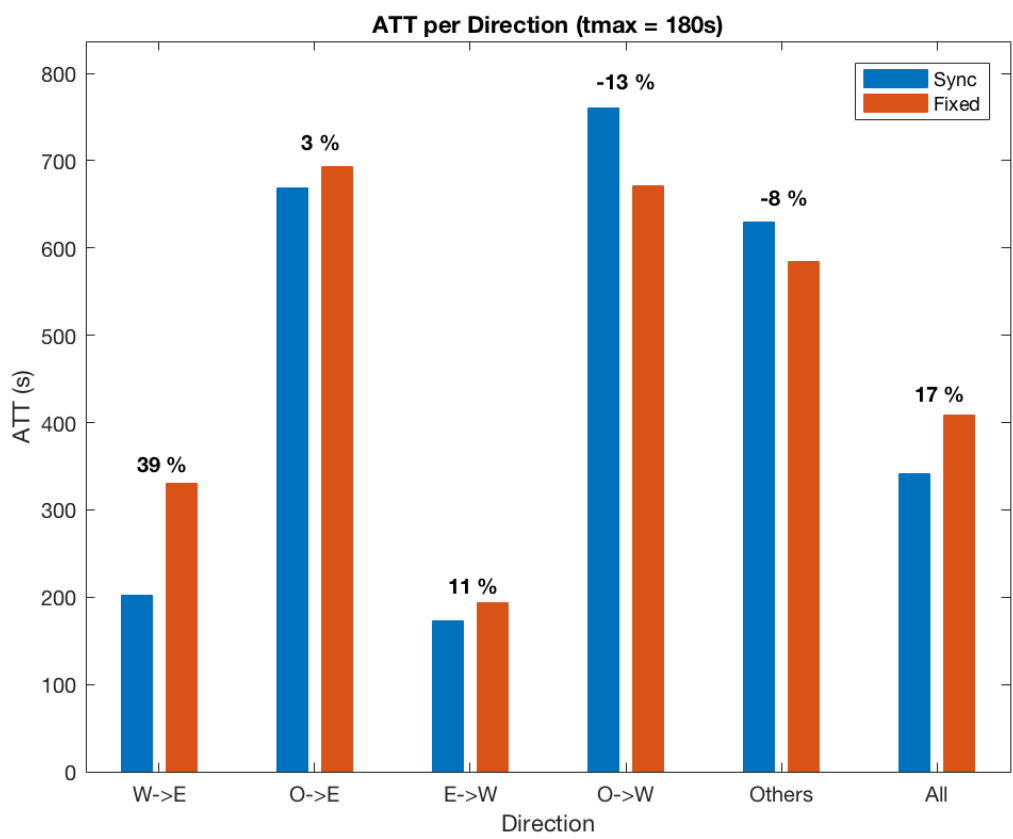
Figure 16. The achieved ATT in different travel